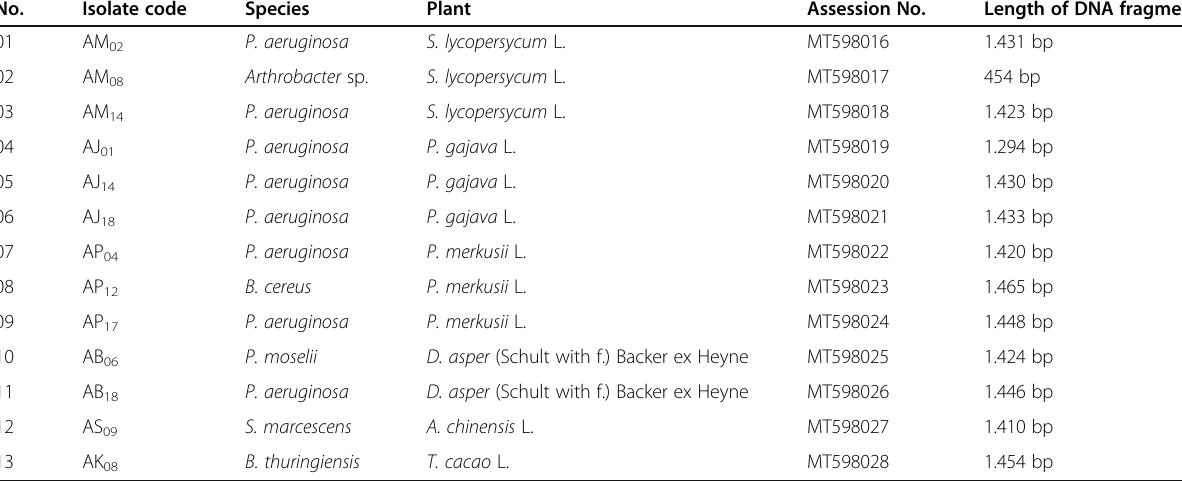
Table 2 Sequencing DNA from 13 endophytic bacteria isolates No. Assession